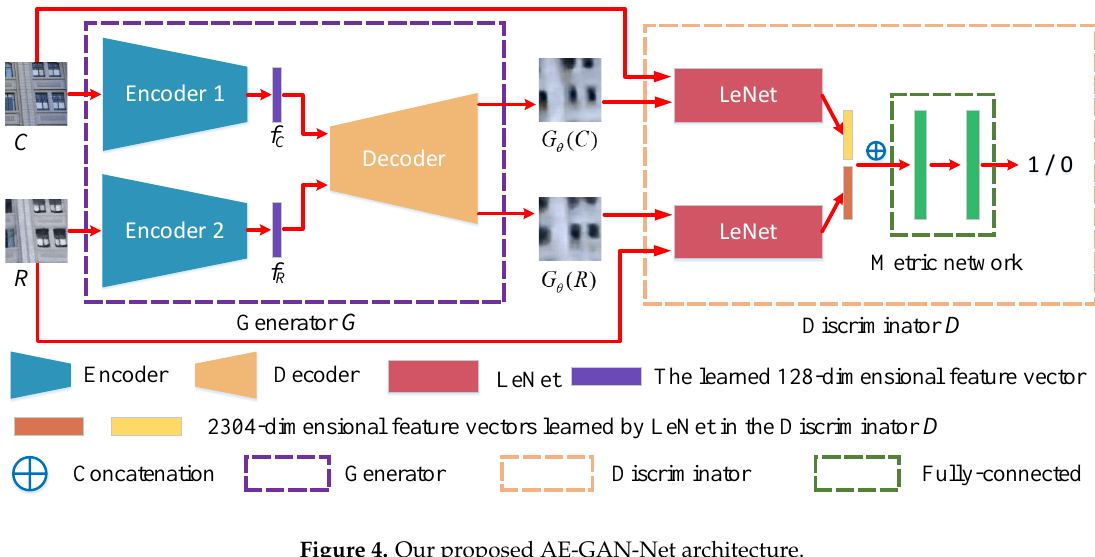
Figure 4. Our proposed AE-GAN-Net